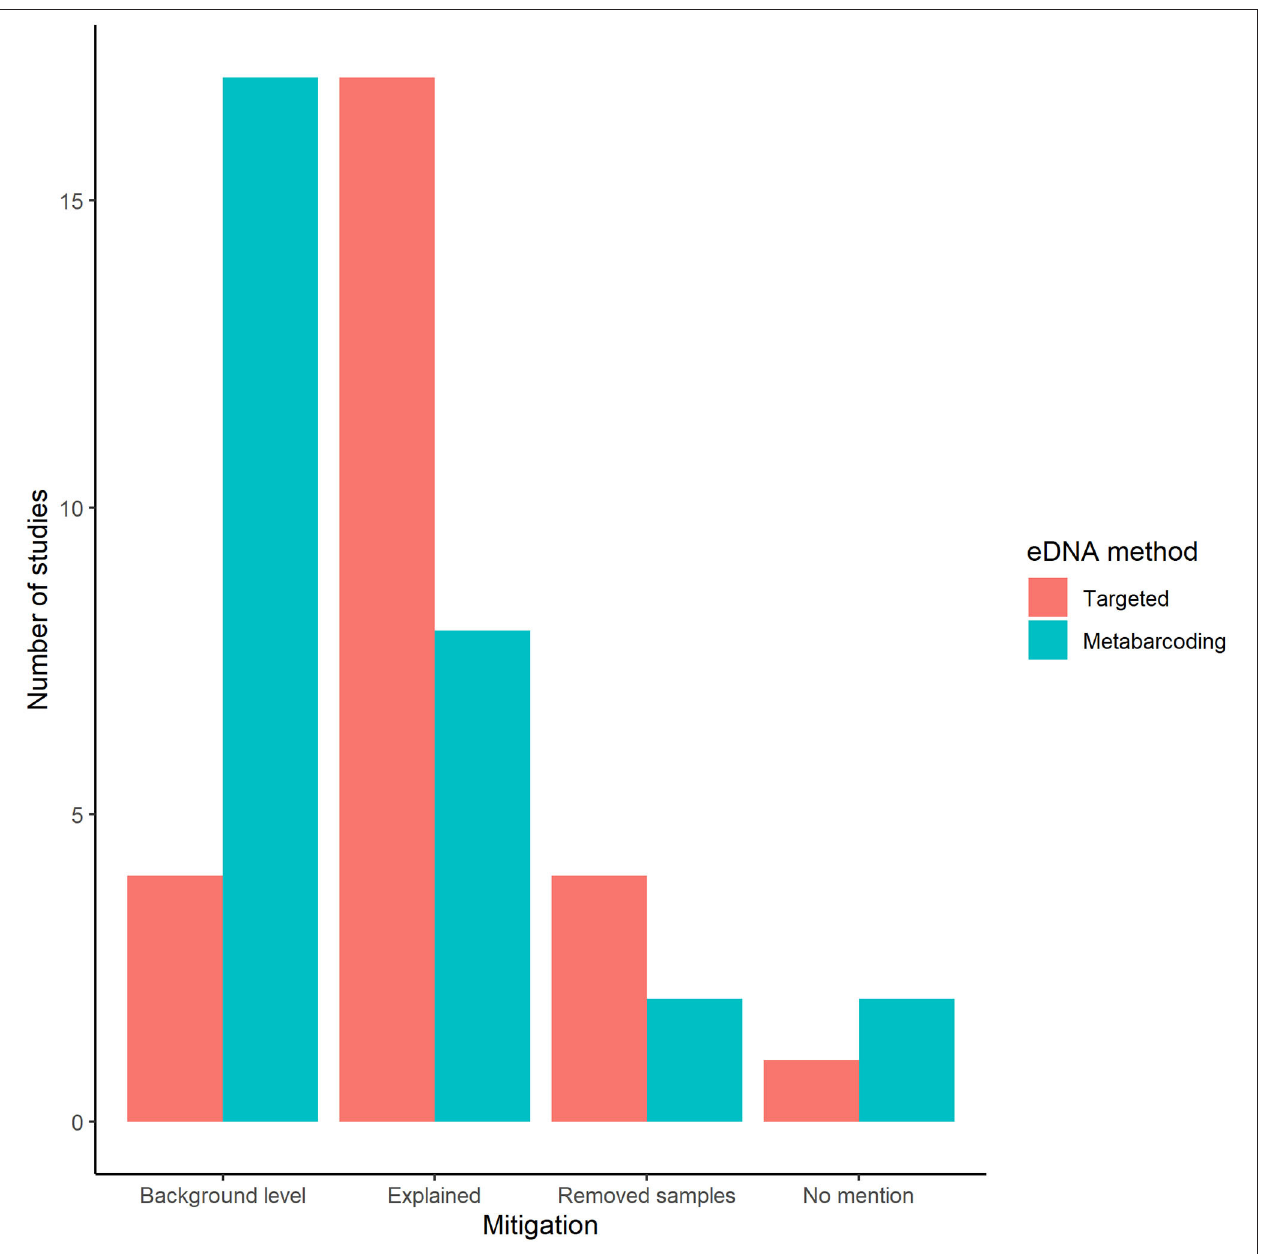
FIGURE 5 | The number of studies in the second literature review that used amplified negative controls to delimit a detection threshold above which is considered significant (Set as background level), provided rationale for why the unexpected amplifications did not affect results (Explained away), removed field samples that were associated with negative controls that amplified (Removed samples), or reported amplification but did not provide rationale for why these results could be ignored (No